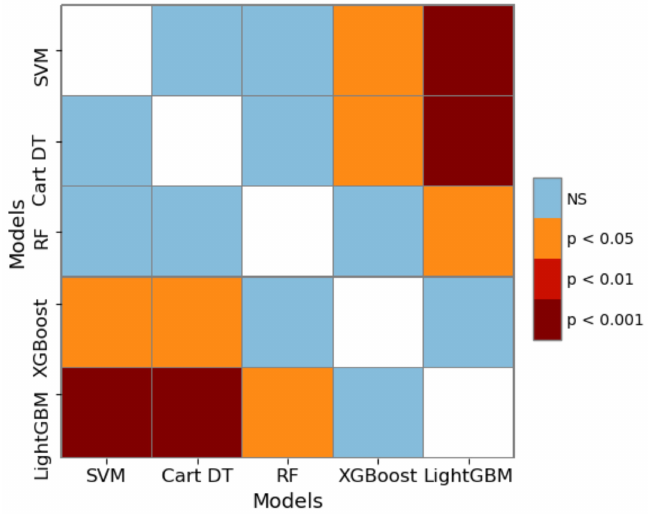
Figure 16. The p -value matrix heat map of Friedman test under criterion MAE. The data is from Table 7. NS stands for insignificant. The darker the color, the more significant the difference between the algorithms.